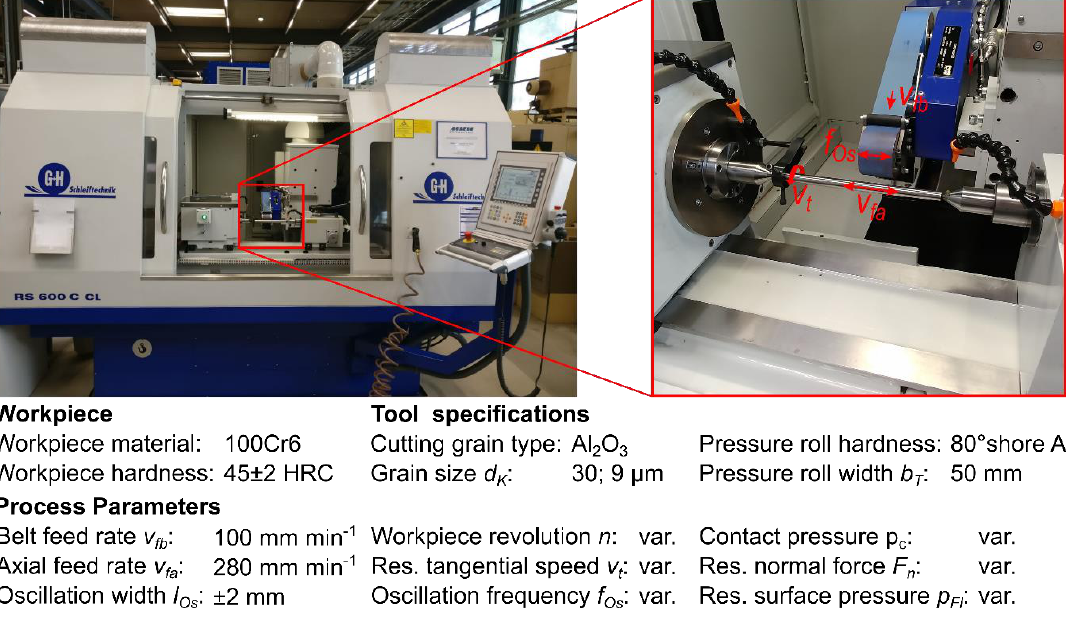
Figure 4. Overview of the experimental set-up periphery using a cylindrical grinding machine and a belt-finishing device. Table 2. Process parameters and tool specifications on the microfinishing steps.